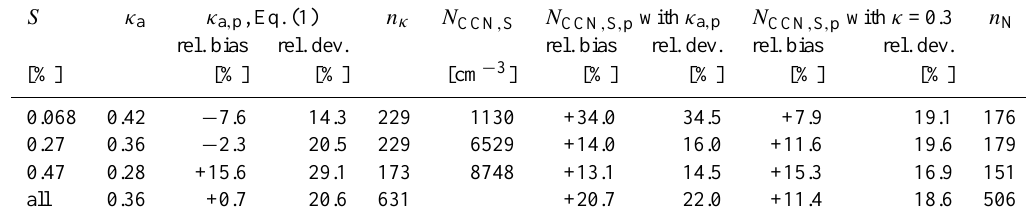
Table 3. Arithmetic means of the observed κ a and N CCN , S values, and characteristic deviations between predicted values ( κ a , p and N CCN , S , p ) and those observed (relative bias and total relative deviation, including systematic and statistical errors) for the entire campaign. n κ and n N are the number of data points that are contained in the averages of κ a , p and N CCN , S , p ,